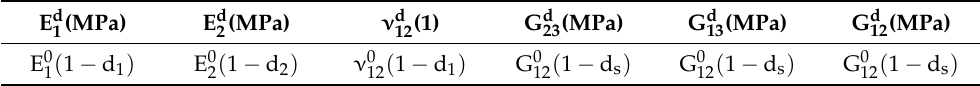
Table 6. Proper elastic properties of damaged lamina.